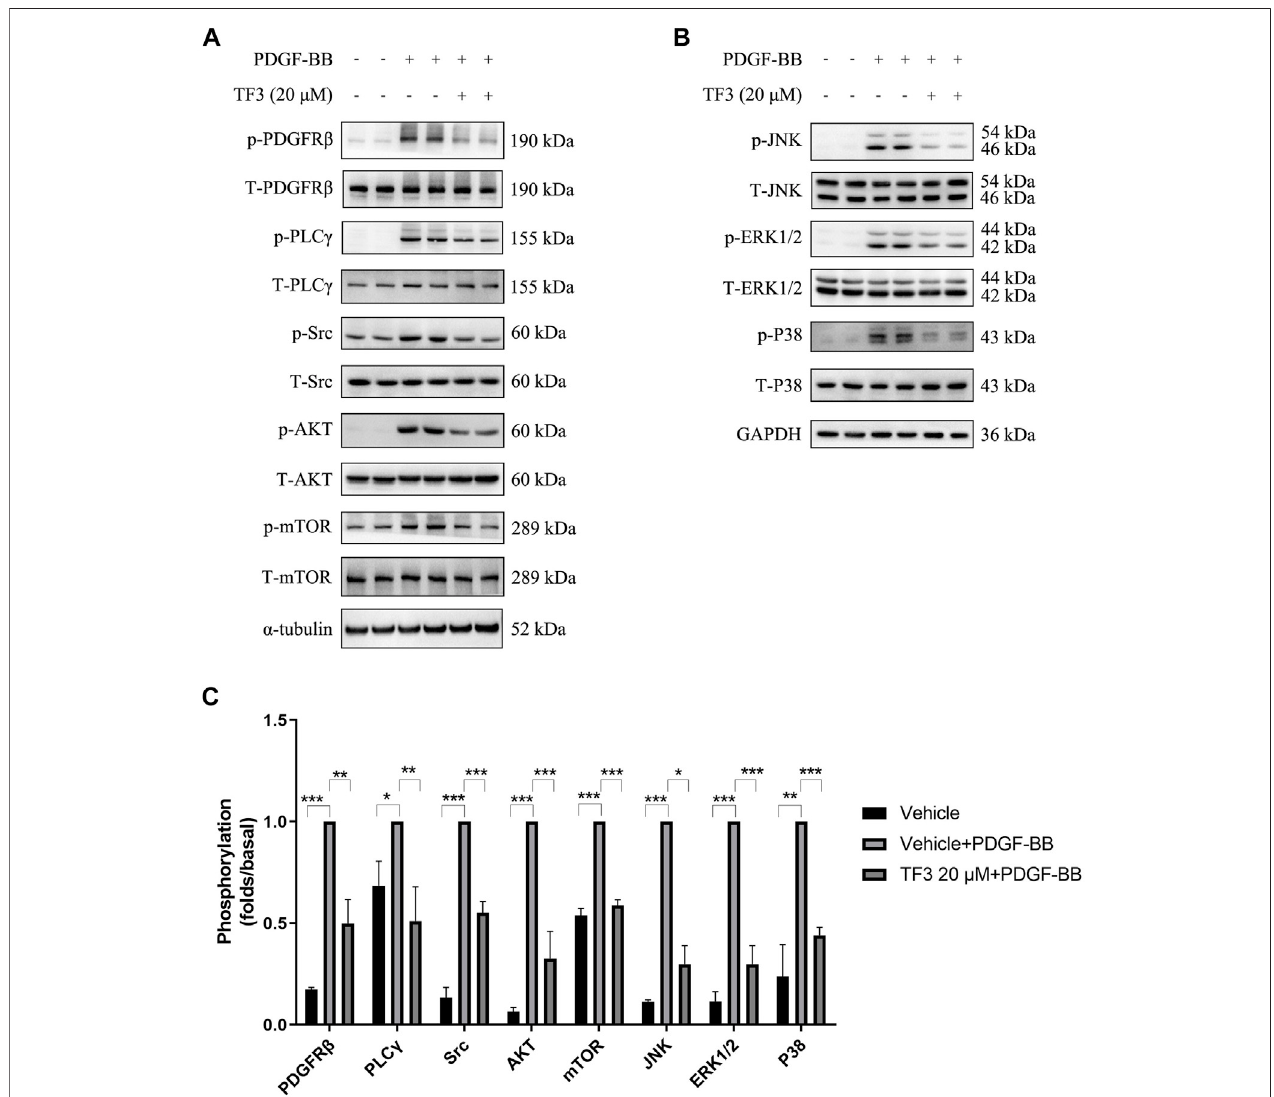
FIGURE 6 | Thea fl avin-3,3 ′ -digallate (TF3) suppresses the activation of PDGFR β and its downstream pathways in PDGF-BB – induced rat aortic smooth cells (RASMCs).Thecellswereserum-starvedfor24handthenstimulatedwithPDGF-BB(20ng/ml)withorwithoutpretreatmentwith20 μ MTF3.Cellextractwasharvested after 10 min of stimulation. (A,B) Western blotting was performed using antibodies against the classical PDGFR β and MAPK signaling pathways. (C) The statistical data of the western blot are shown. Each experiment was performed in triplicate. * p < 0.05, ** p < 0.01, *** p < 0.001.